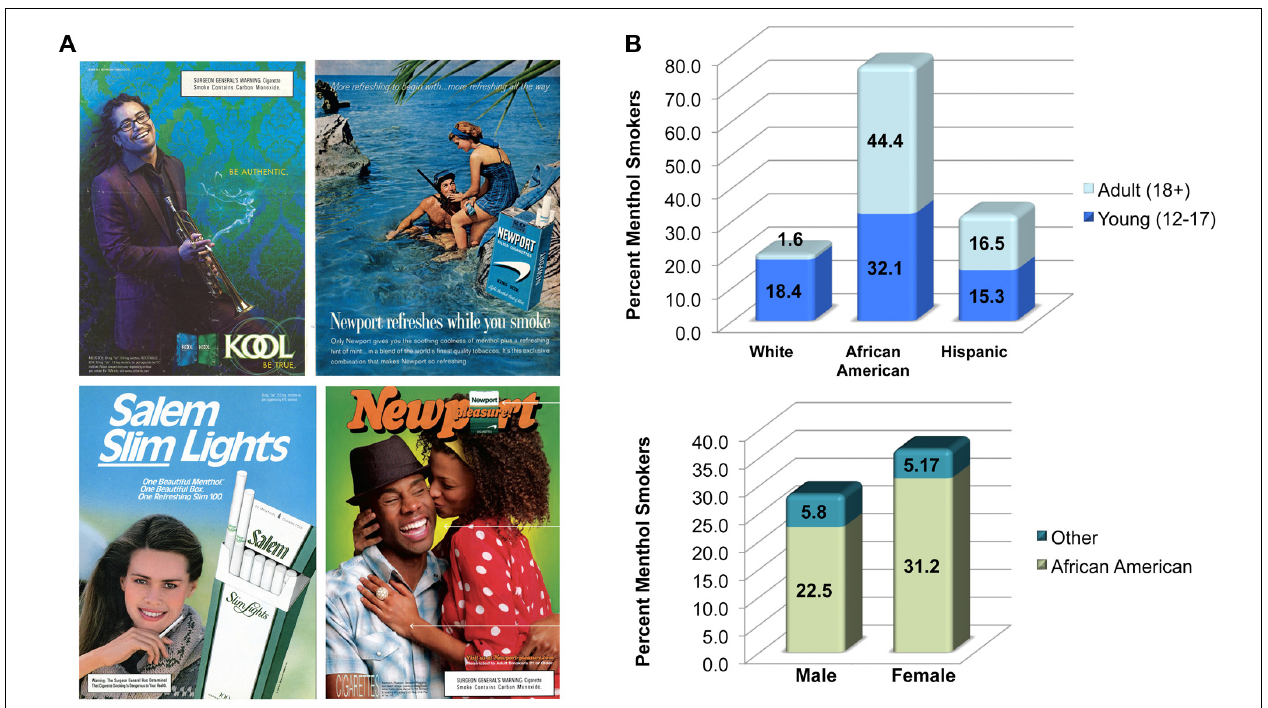
FIGURE 1 |Who smokes menthol cigarettes? (A) Advertisements used in the marketing and branding of menthol cigarettes. (B) Data gathered from the Tobacco Products Scientific Advisory Committee’s original report (Wilson, 2011) on the percent menthol smokers in various ethnic, racial, gender, and age groups.Values are based on data obtained in